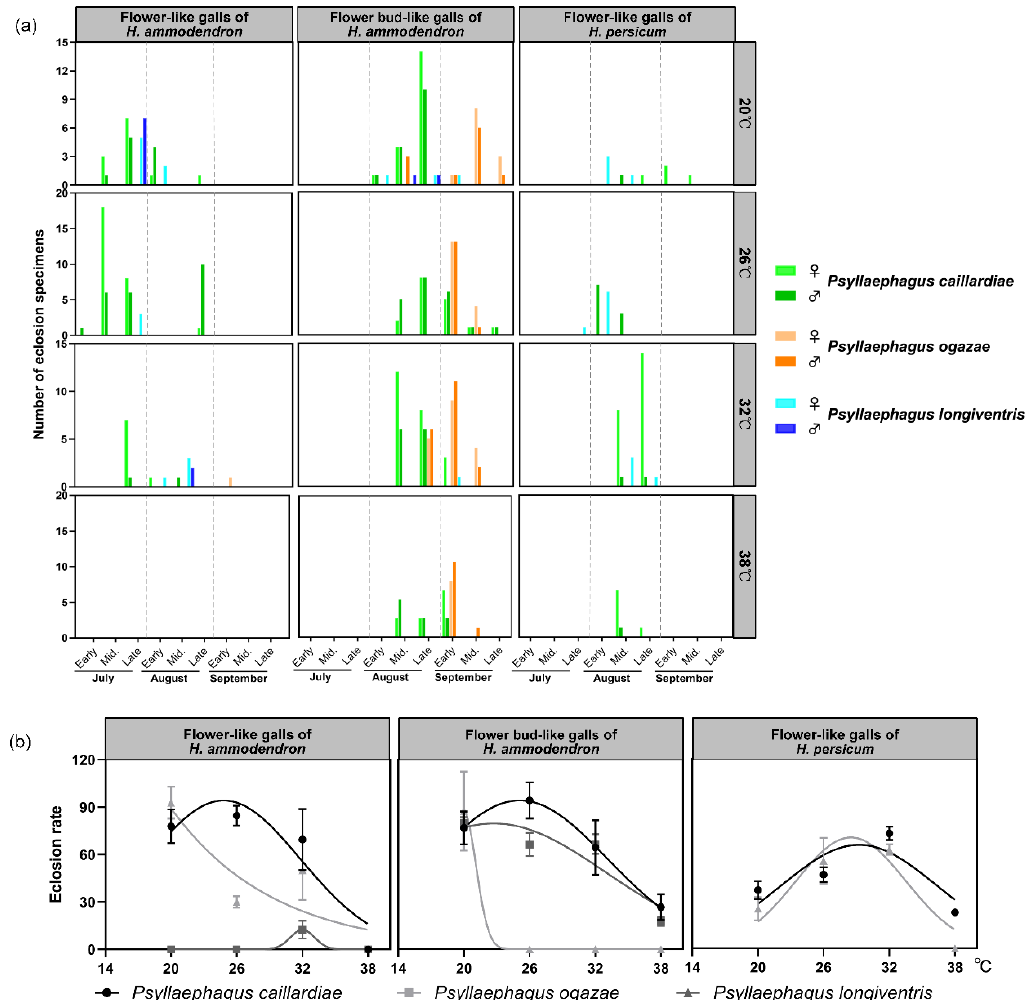
Figure 3. Emergence periods ( a ) and emergence rate effects ( b ) of parasitoids of flower-like galls on Haloxylon at four different temperatures of 20, 26, 32, and 38 °C. The emergence of individuals from flower-like galls was investigated daily under lab conditions in Fukang, China. Midpoints mean the average value. The regression line shows the trend of emergence rate with temperature.